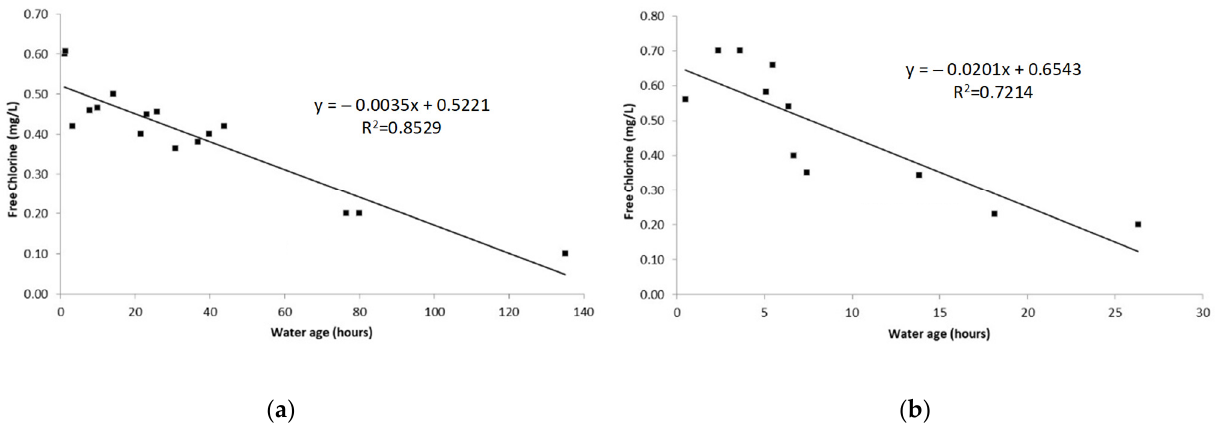
Figure 7. Mean water age and chlorine concentrations at the sampling nodes in Case Study 2 in ( a ) winter and ( b ) summer.